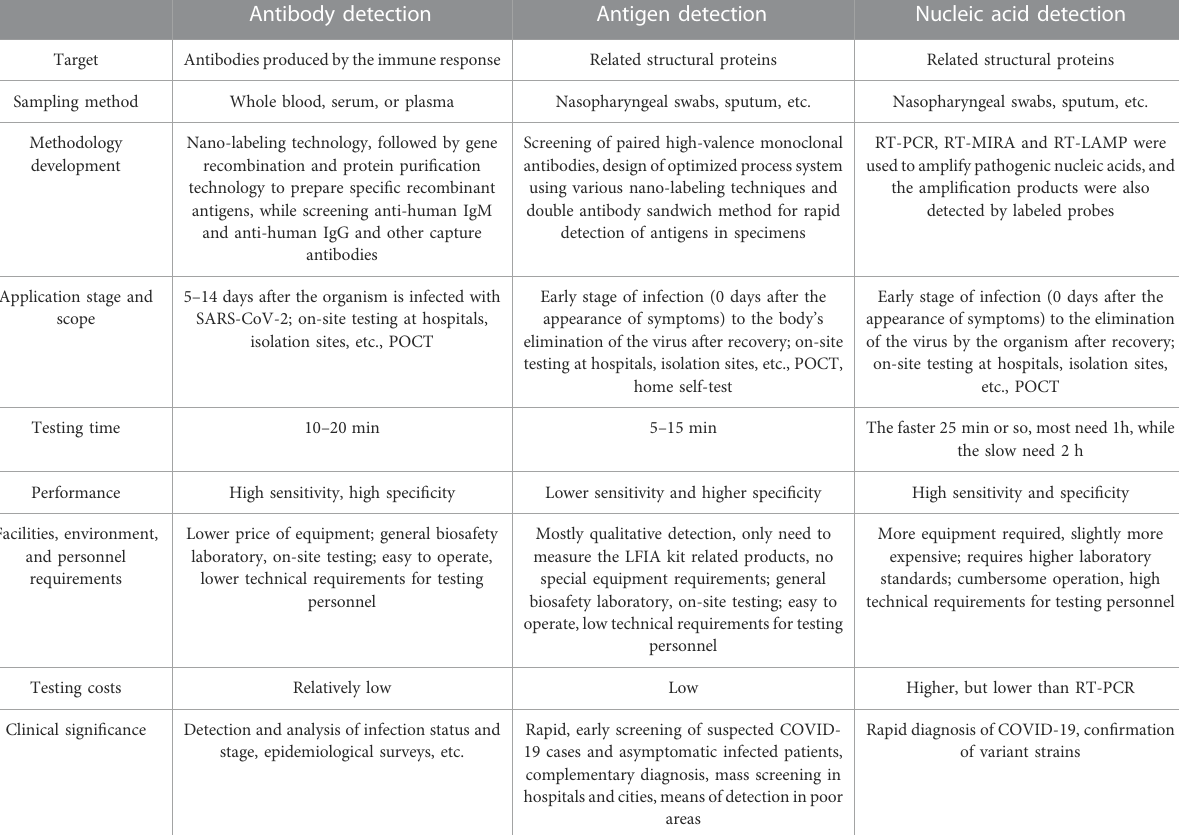
TABLE 3 Differences, advantages, and disadvantages of LFIA for antibody, antigen and nucleic acid